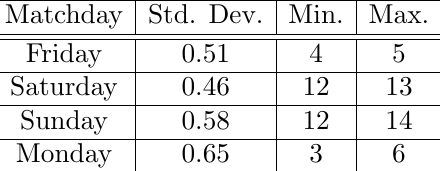
Table 8. Summary statistics for the optimal schedule in the entire season.